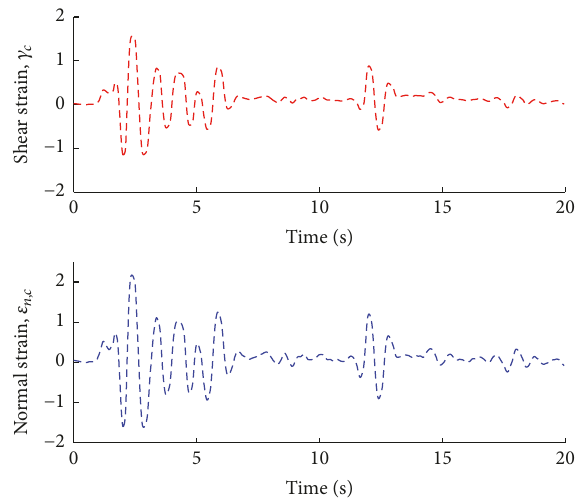
Figure 20: The normal strain and shear strain time histories of critical plane.